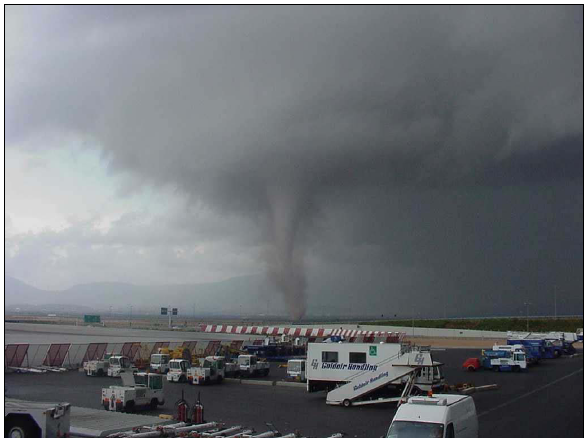
Figure 1. Tornado at Athens International Airport “Eleftherios Venizelos” at 10:20UTC on 27 July Figure 1.